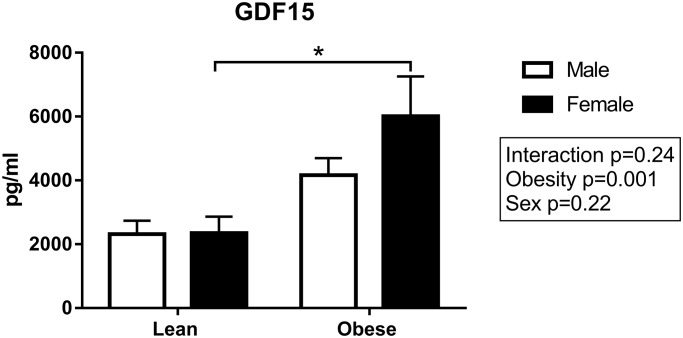
Higher levels of growth differentiation factor 15 (GDF15) in obese ZSF1 rats.GDF15 levels were measured in plasma collected at the end of the protocol. Means ± SEM. Male obese N = 9; female obese N = 7; male lean N = 7 and female lean N = 6. *P<0.05.